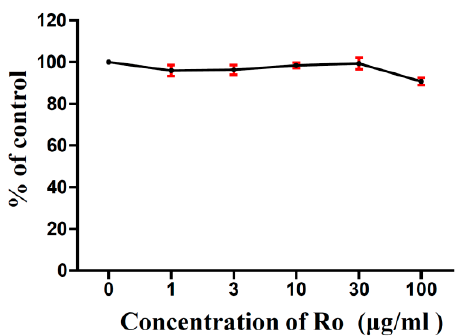
Figure 2. Effects of Ro on B16F10 melanoma cell viability. The results of the control (0 μ g/mL) were normalised to 100%, and the results from Ro-treated cells were expressed as % of the control.